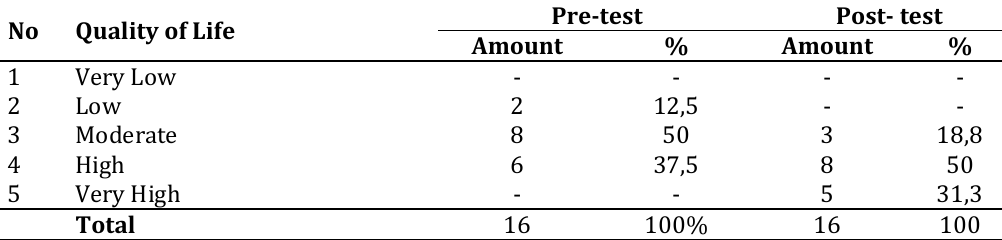
Quality of Life Level in the Treatment Group